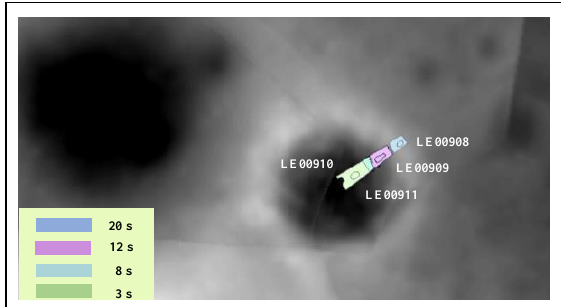
Figure 12. Predicted VNIS FOVs on DEM of the four movements.